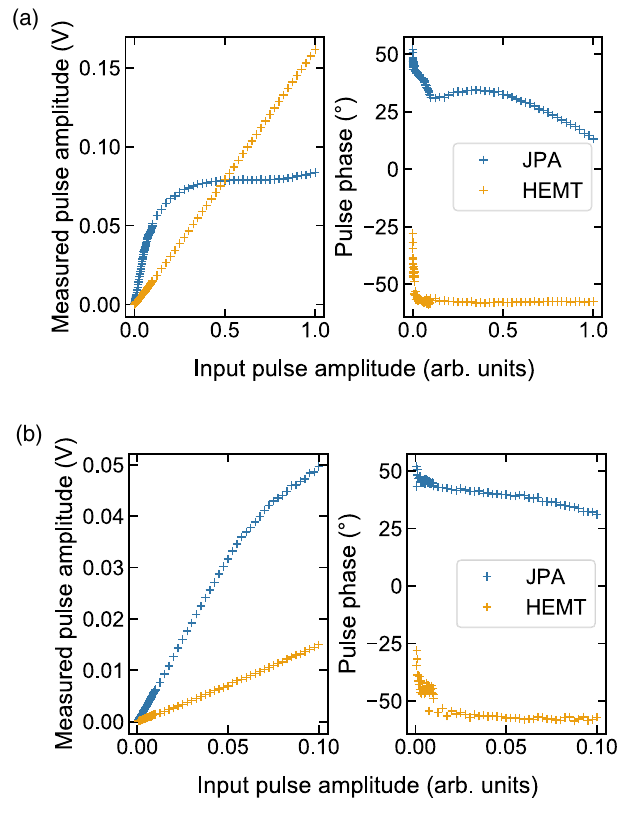
FIG. 11. (a) Measured pulse amplitude as a function of input pulse amplitude, measured using the JPA (blue) and the HEMT without JPA (orange). (b) Low-power regime of the same